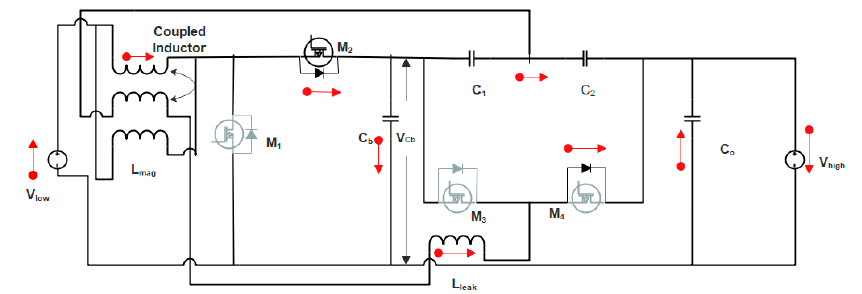
Figure 9. Equivalent circuit for mode VII.